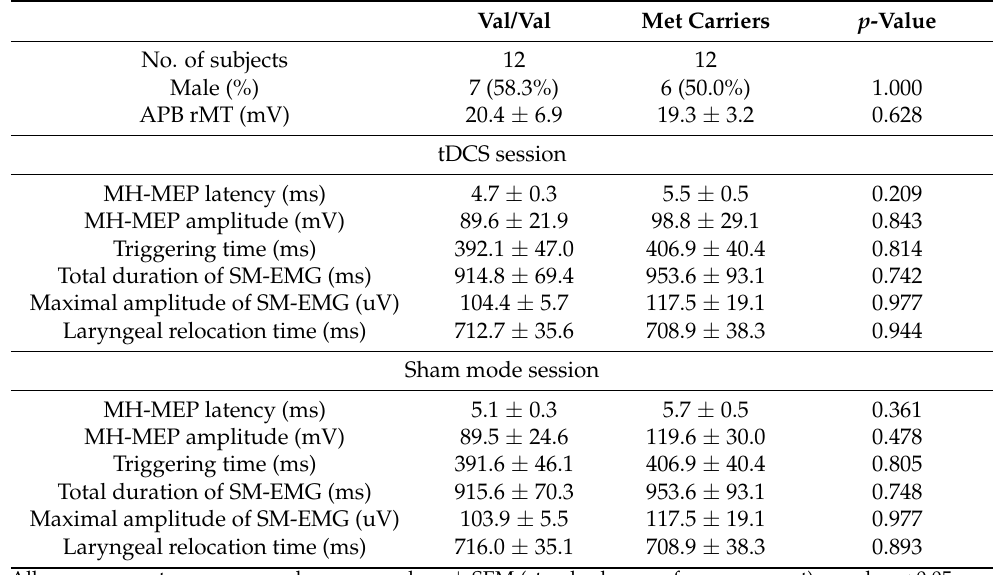
Table 1. Assessments of the participants according to the genotypes at the